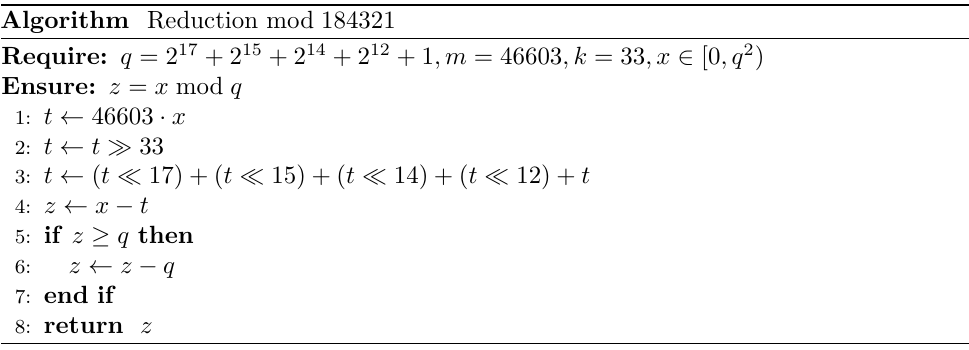
Algorithm Reduction mod 184321